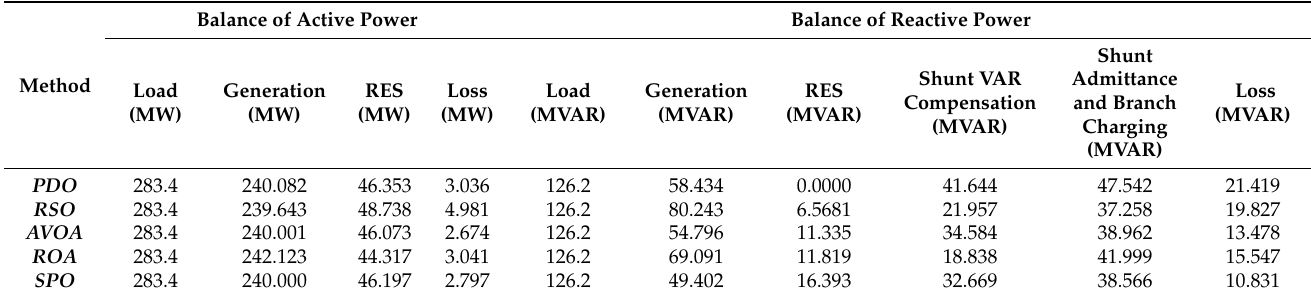
Table 16. Balance of active and reactive power for proposed algorithms with case 4.